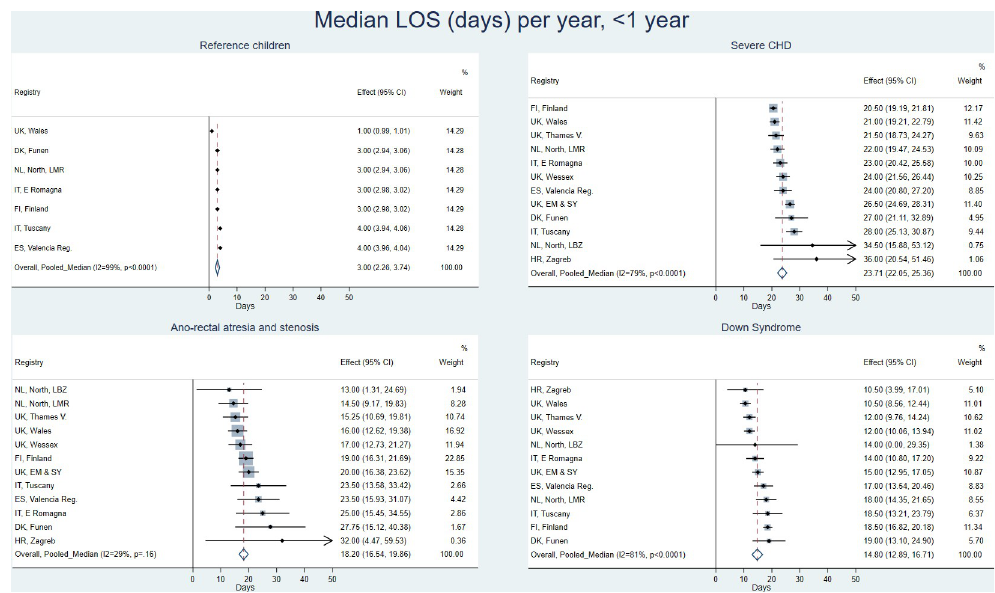
Fig 2. Meta-analysis of median length of stay in children < 1 year for selected anomaly subgroups and reference children. Registry specific median LOS in days and pooled median LOS in days estimated from meta-analysis of all available registries. Median LOS calculated only among children hospitalised < 1 year. Registries with < 3 cases in subgroup not included. Data from the Northern Netherlands LBZ database not included for reference children < 1 year because outpatient contacts in 2013 were recorded as admissions and < 1 year data were therefore excluded. CHD = Congenital Heart